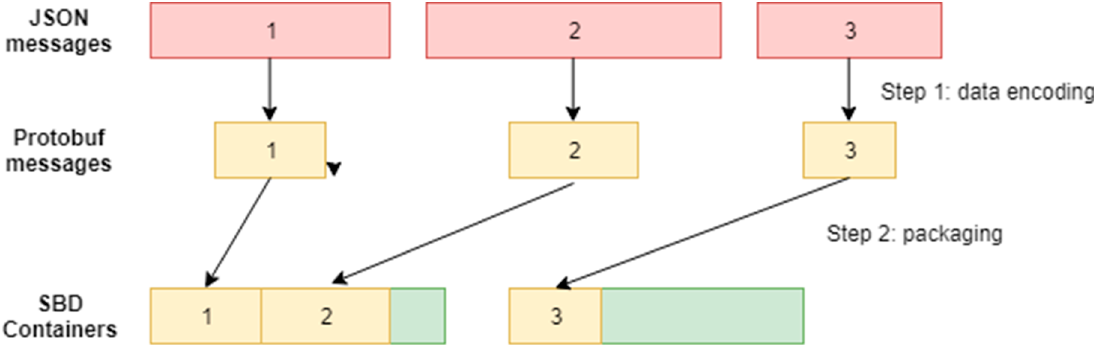
Figure 3. Scheme of the Gateway Encoding and Packaging (GDEP) Figure 3 . Scheme of the Gateway Encoding and Packaging (GDEP) method.